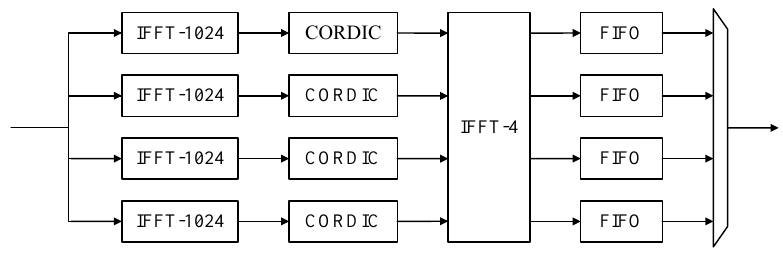
Figure 9. The architecture of parallel IFFT module.